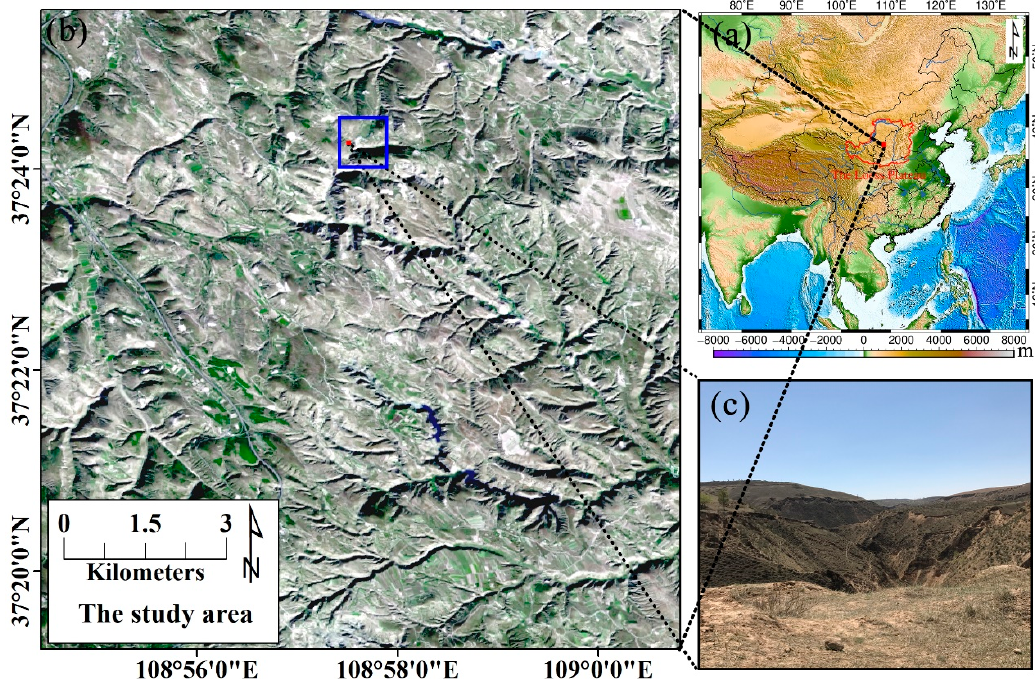
Figure 1. Information of the study area: ( a ) Location of the study area in the Loess Plateau, outlined by the red polygon. ( b ) False color composite image (with R, G, B = band 6, 5, 4) from Landsat-8 Operational Land Imager (OLI) of the study area, acquired on September 28th, 2016. The blue rectangle indicates the area with in situ measurements. ( c ) Surface scenery photo taken on October 19th, 2017. Table 1. Seasonal values of precipitation and potential evapotranspiration in the study area.